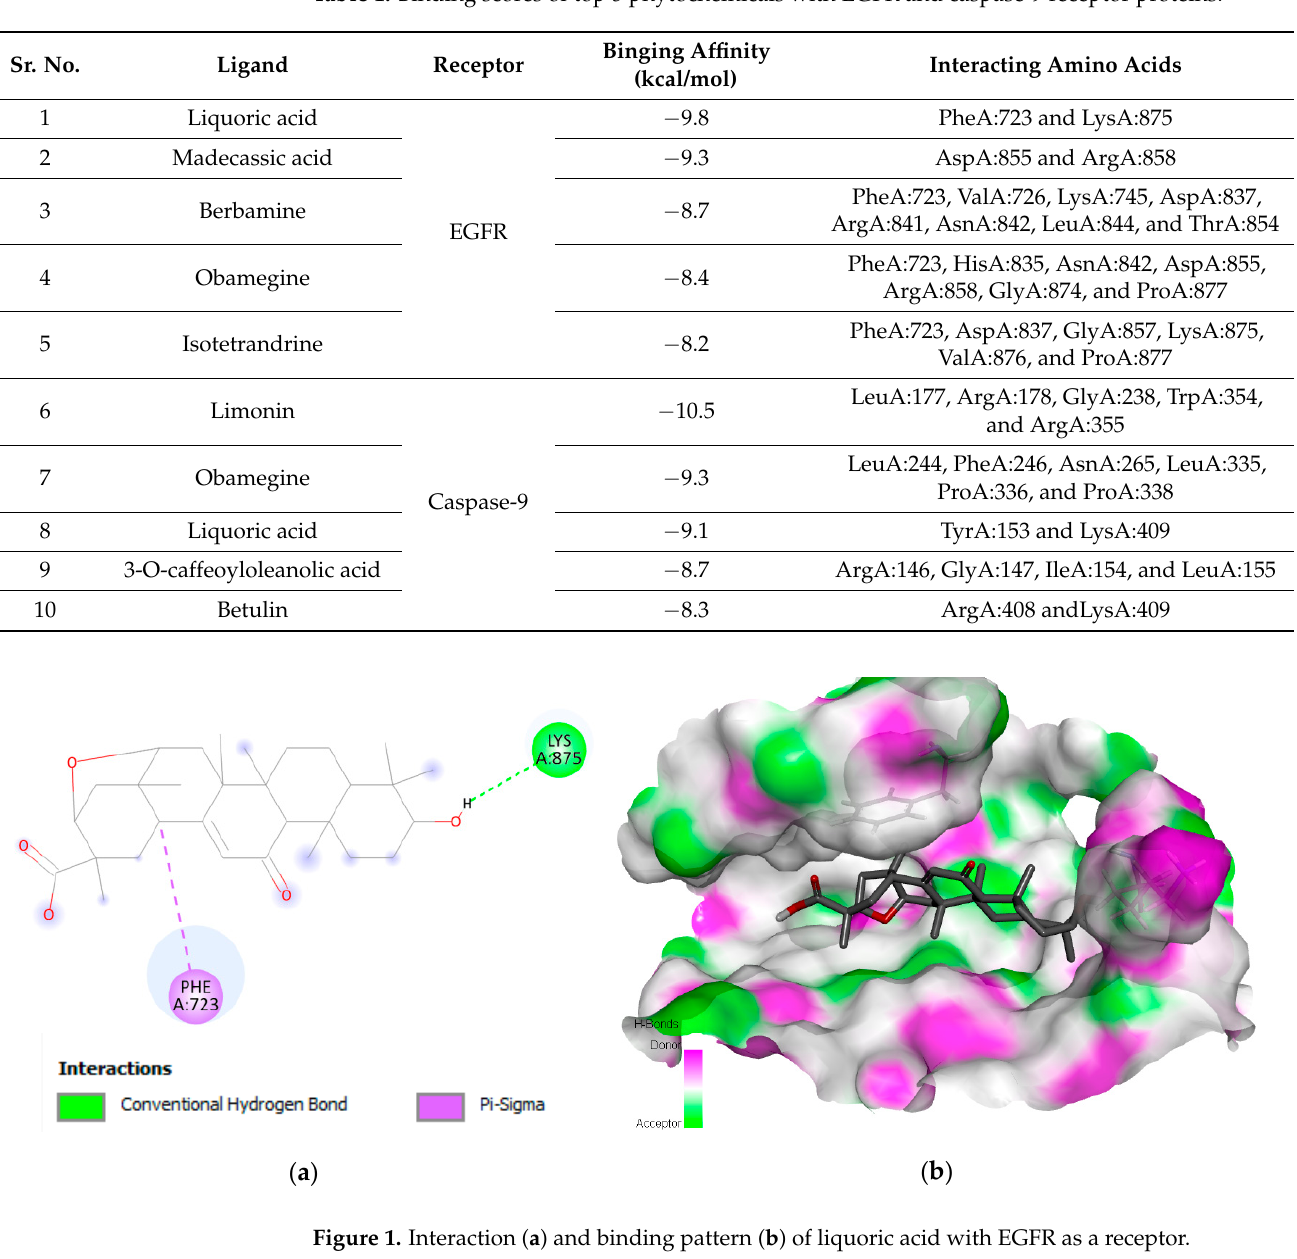
complex. The Pi–sigma interactions (i.e., Pi–alkyl and Pi–sulfur) help to intercalate the drug in the binding pocket of the receptor as they are largely involved in the charge transfer. Table 1. Binding scores of top 5 phytochemicals with EGFR and caspase-9 receptor proteins.